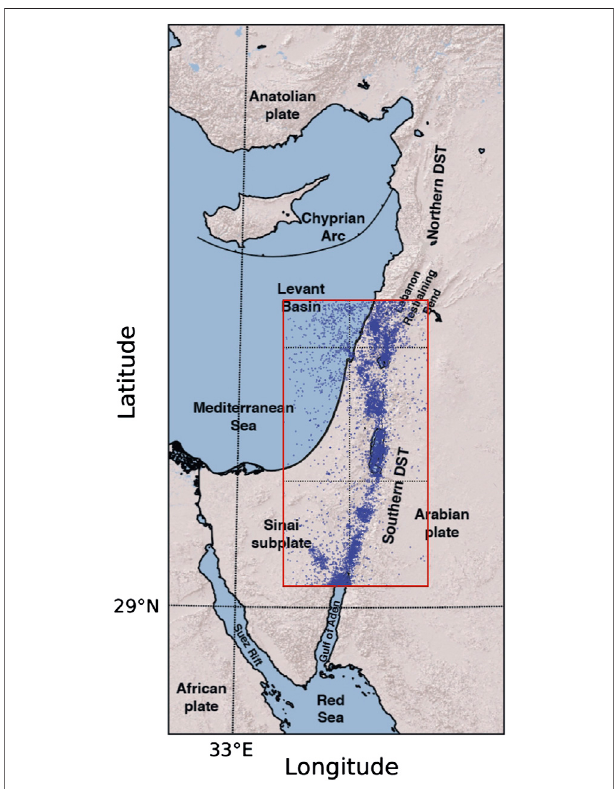
FIGURE 1 | Tectonic setting for Israel and seismic map of the earthquakesincludedintheIsraelicatalog.Theredboxistheareaselectedfor the